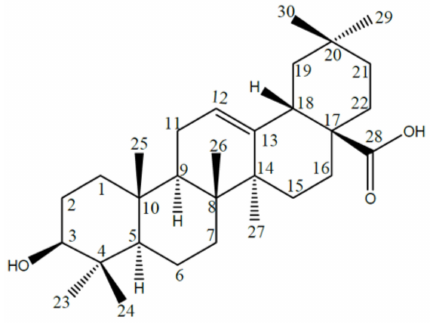
Figure 1. Chemical structure of oleanolic acid.